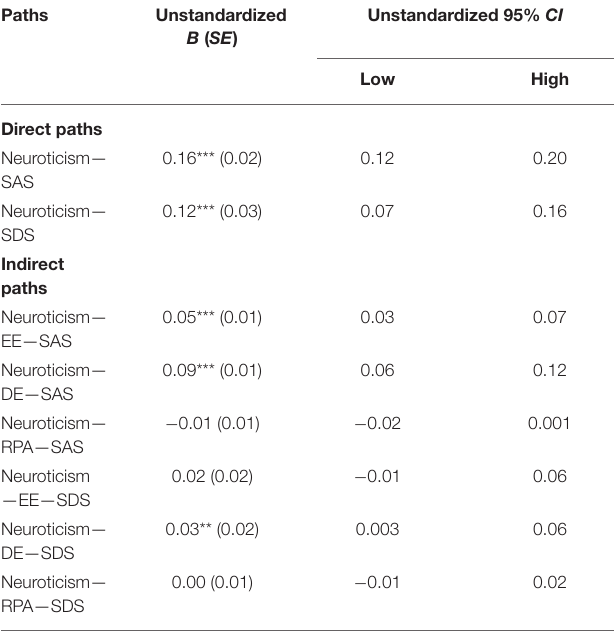
TABLE 4 | Test of mediating